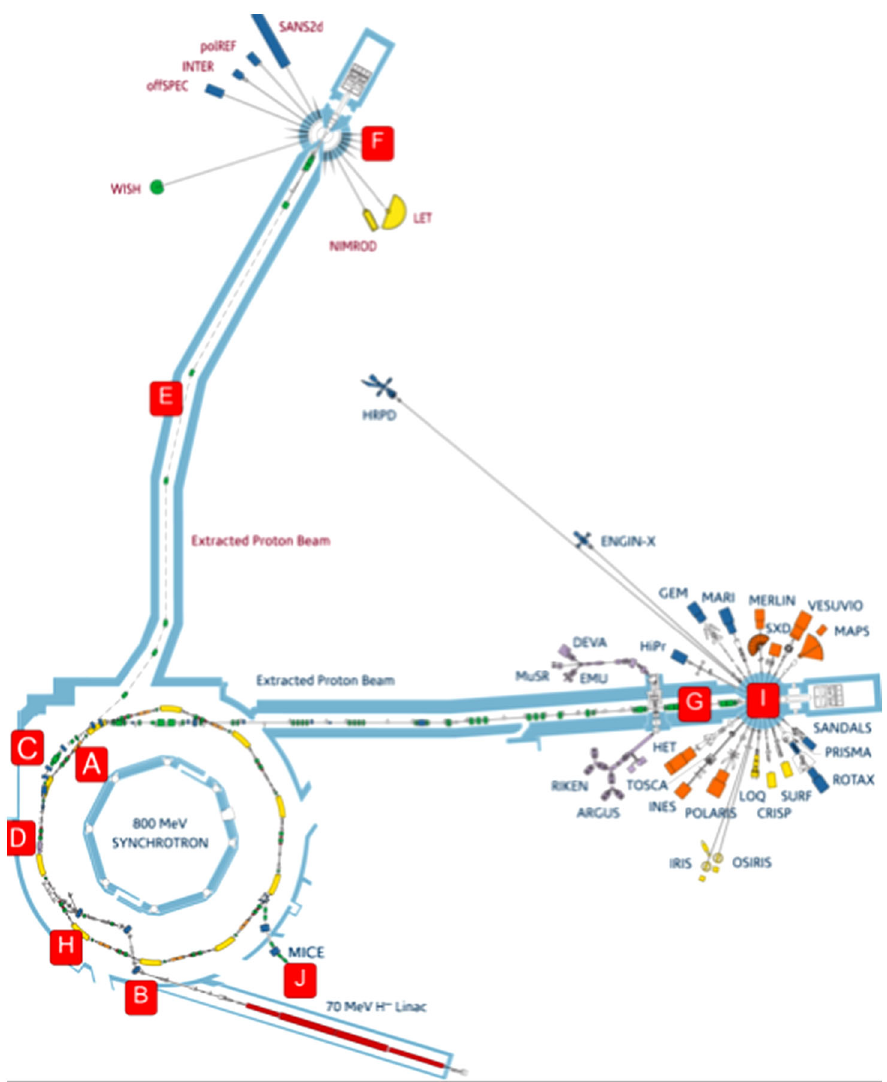
FIG. 1. Layout of the ISIS facility at the Rutherford Laboratory. The muon target (G) is situated 20 m upstream of the neutron target (I). The second neutron target is also shown